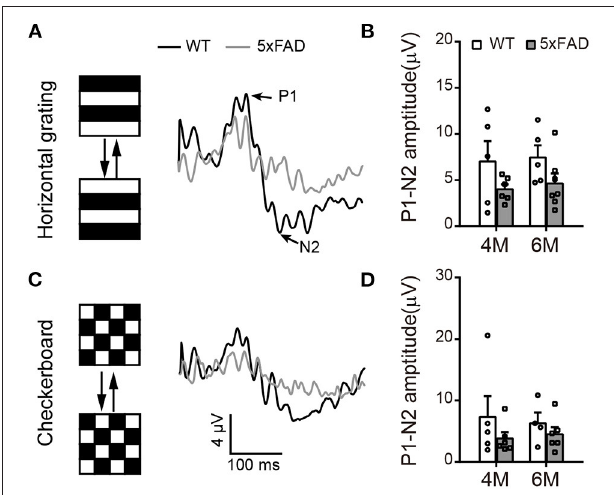
FIGURE 5 | Pattern ERG response tend to decrease in 5xFAD. (A,C) Example traces of pattern ERG responses to (A) horizontal gratings or (C) checkerboard from a WT and 5xFAD mice. (B,D) Scattered plots of the P1-N2 amplitudes under stimuli of (B) horizontal gratings or (D) checkerboard. Data shown as mean ±